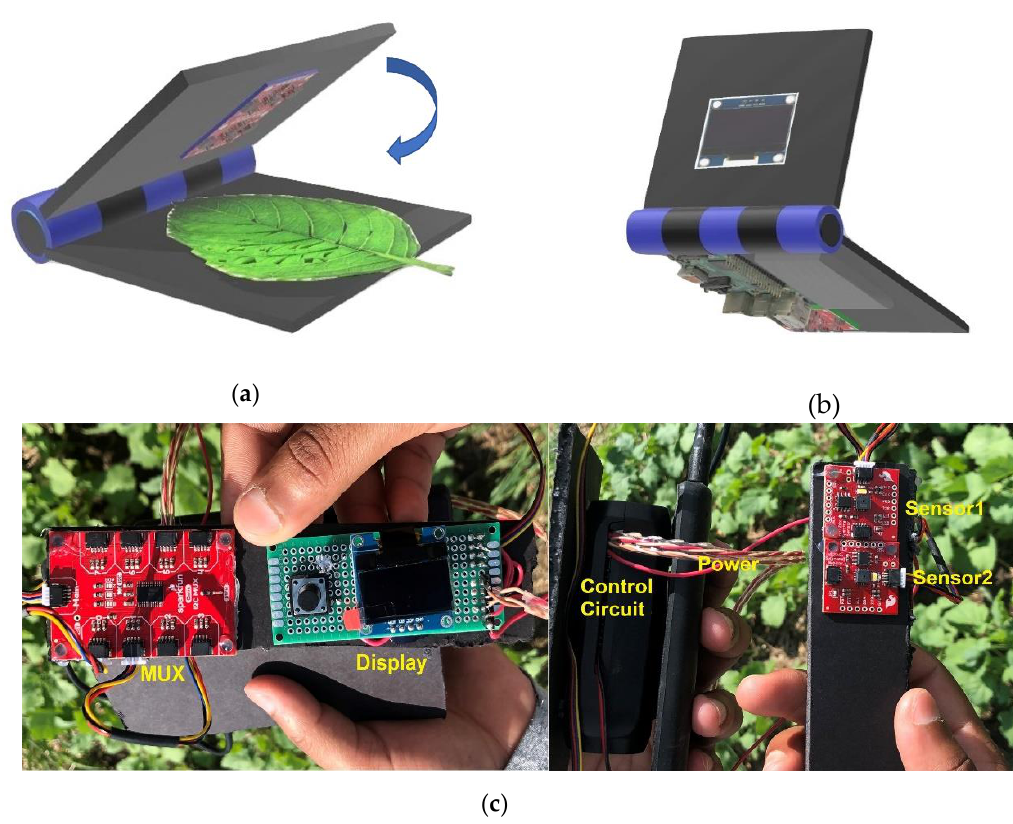
Figure 1. ( a ) The leaf is placed in between the clips; Sensor1 and Sensor2 touch the leaf during scanning. ( b ) Back view of the graphical set-up. Components of the sample device ( c )—multiplexer (MUX), display, control circuit, power, Sensor1, and Sensor2.